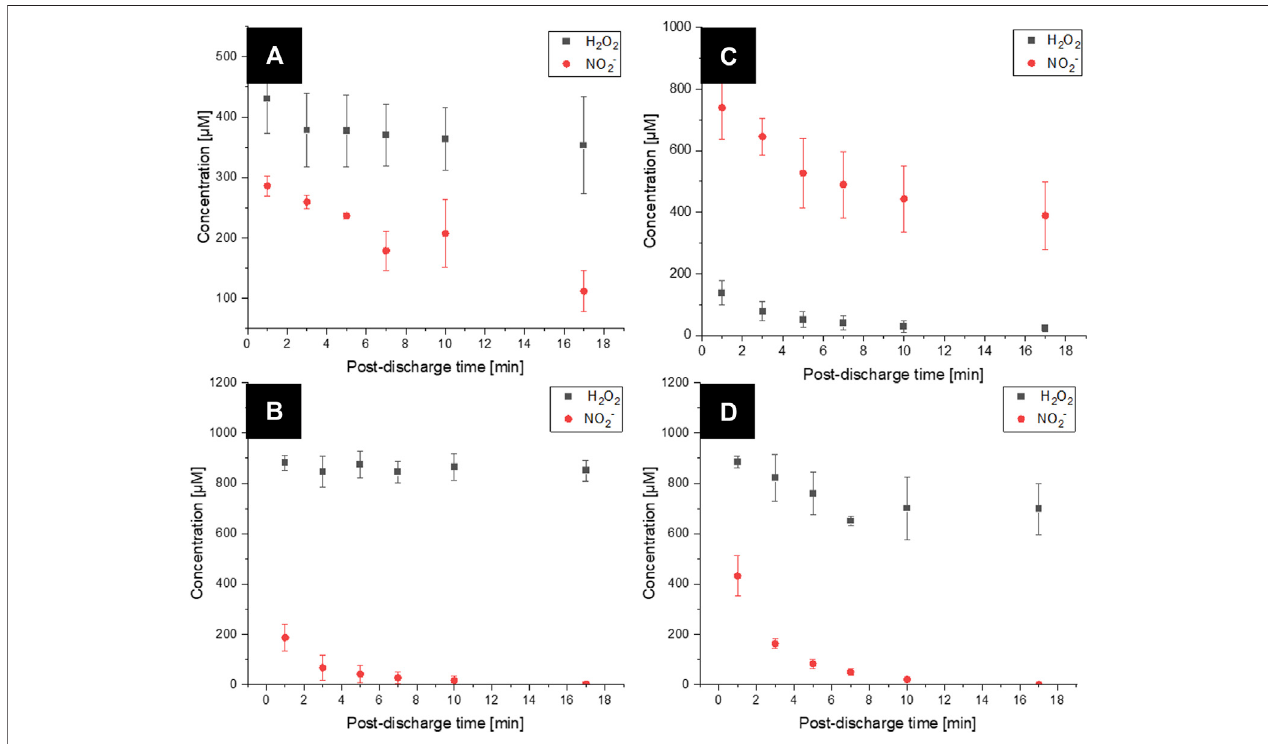
FIGURE 5 | Temporal evolution of H 2 O 2 and NO − 2 concentrations in PAW prepared by (A) TS-ES (1 ml/min, 1 kHz) in open air. (B) TS-ES after adding 1 mM of